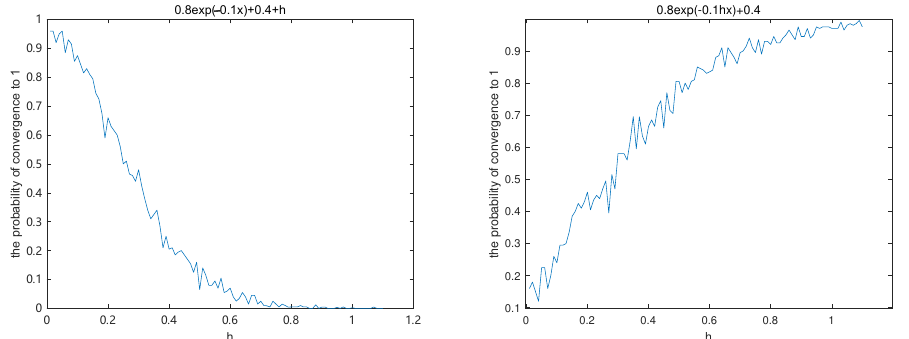
Figure 5. The probability that opinions converge to 1. ( left ): { b i ( t ) } are exponential functions; ( right ): { b ( t ) } are exponential functions. i